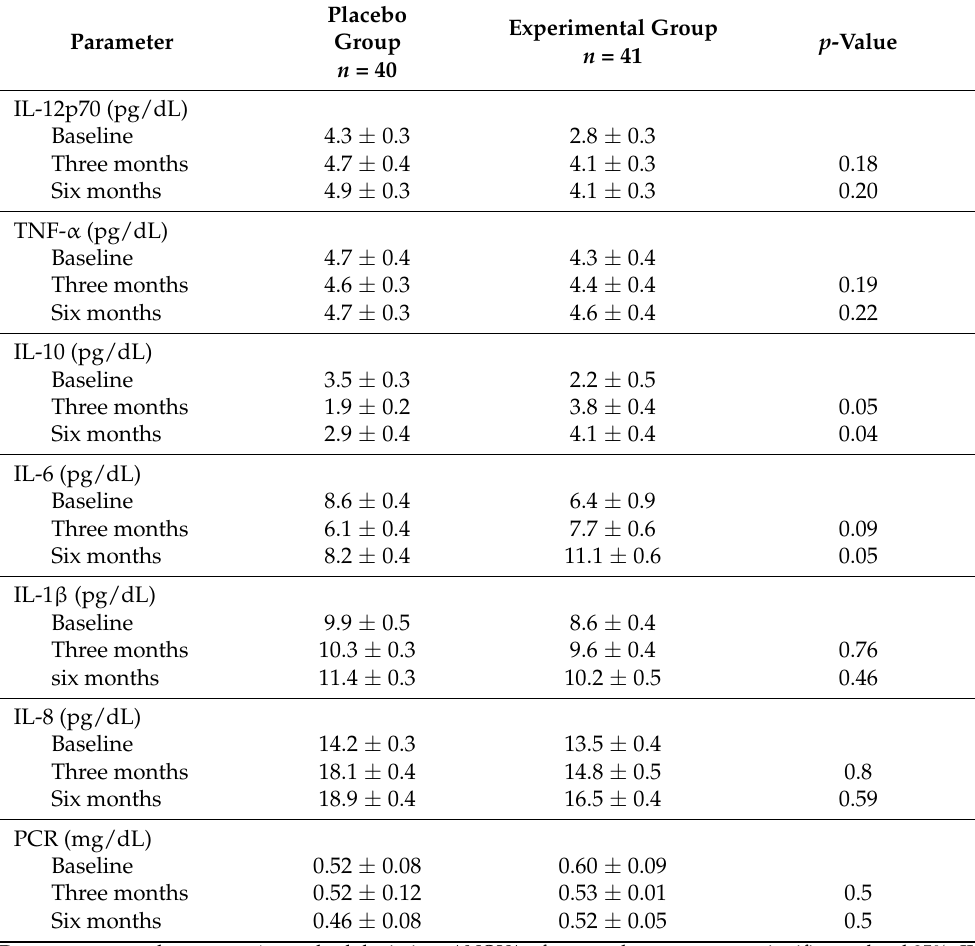
Table 5. Inflammation markers pre- and post-treatment by study group.